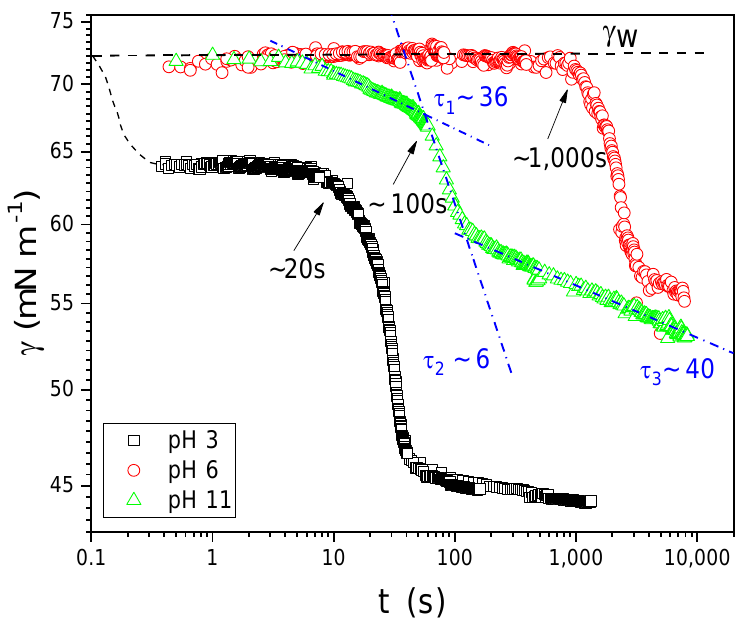
Figure 5. Dynamic surface tension for 1 mgL − 1 PAA mixed with G12 at a concentration of 0.5 mM. Curves for three pHs are shown: pH 3.5 ( squares ), pH 6 ( circles ), and pH 11 ( triangles ). The arrows indicate the induction time at which the surface tension starts to decrease appreciably. The lines superimposed to the curve at pH 11 are fittings with exponentials. We identified at least three processes with distinct characteristic times: τ 1 ~ 36 s, τ 2 ~ 6 s, and τ 3 ~ 40 s.